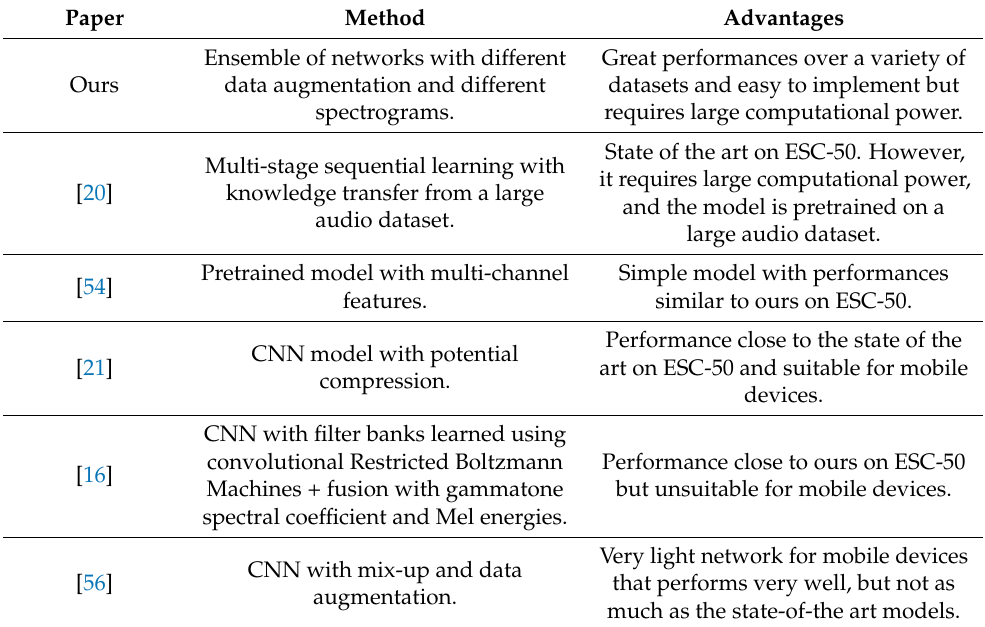
Table 8. Comparisons among the different approaches of audio